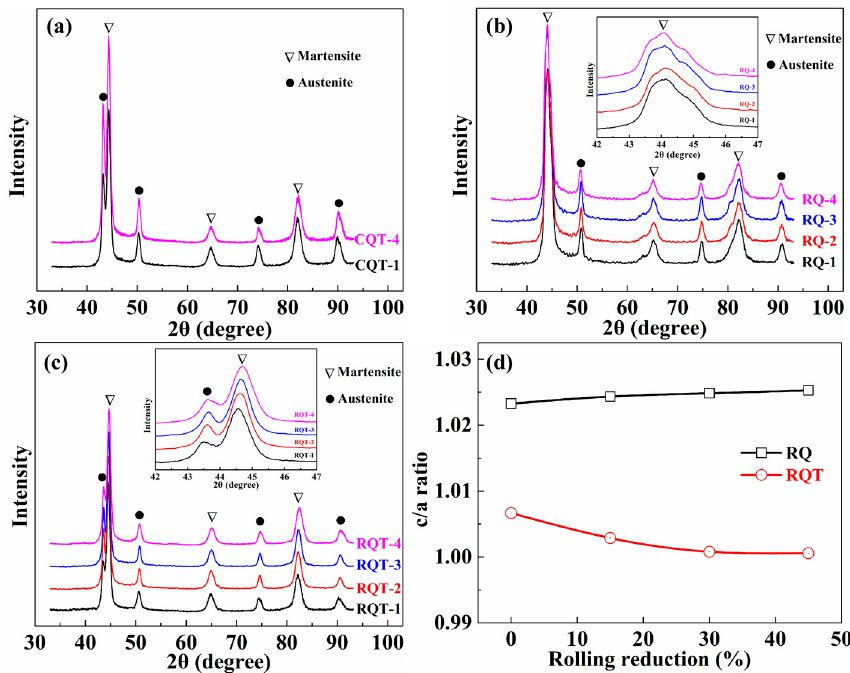
Figure 7. The XRD diffraction of specimens with different hot rolling reductions: ( a ) CQT; ( b ) RQ; ( c ) RQT; ( d ) the c/a ratio of RQ and RQT specimens.